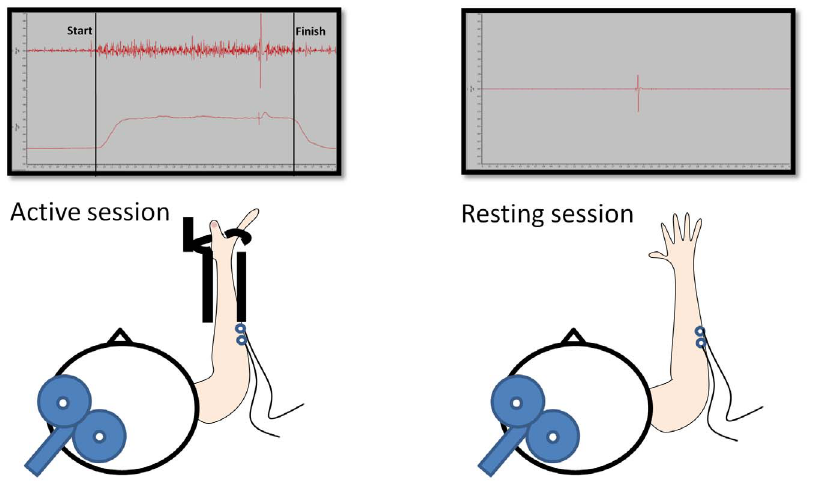
Figure 2. Testing setup. In the active sessions (left), subjects contracted their right ECR at 10% of maximum voluntary contraction during TMS measurement. In the resting sessions (right) subjects were passively resting their right arm on the table. Exemplary EMG activity is shown in the upper panels.